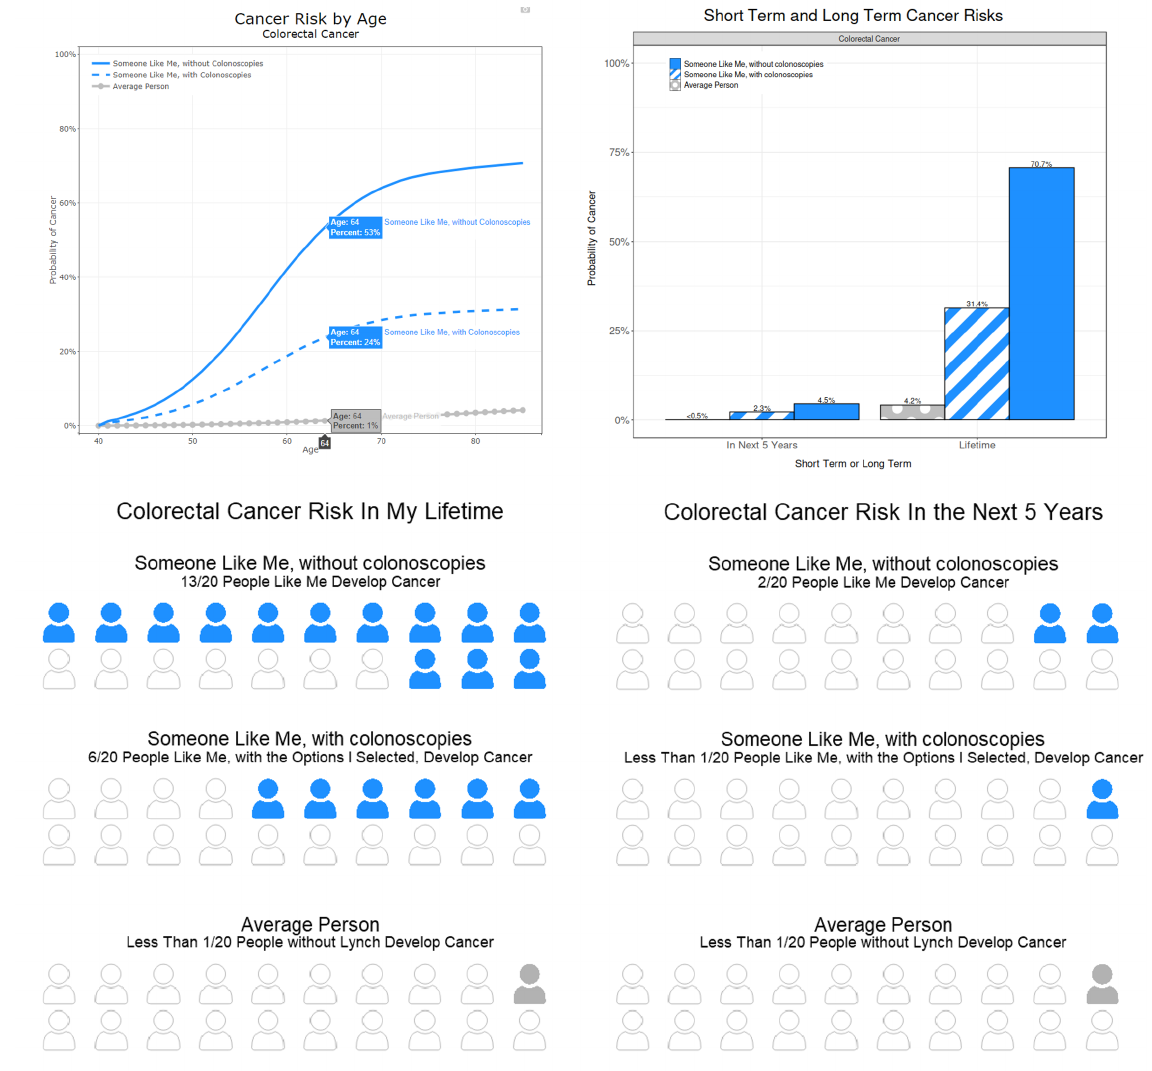
Figure 2. Three visualization options available to the user, a line graph (top left), a bar graph (top right), and personographs (bottom), each conveying the same information: the CRC risk over time, with and without regular colonoscopies, for a hypothetical 40-year old male, with an unspecified race and ethnicity, a MSH6 PV and no previous cancer